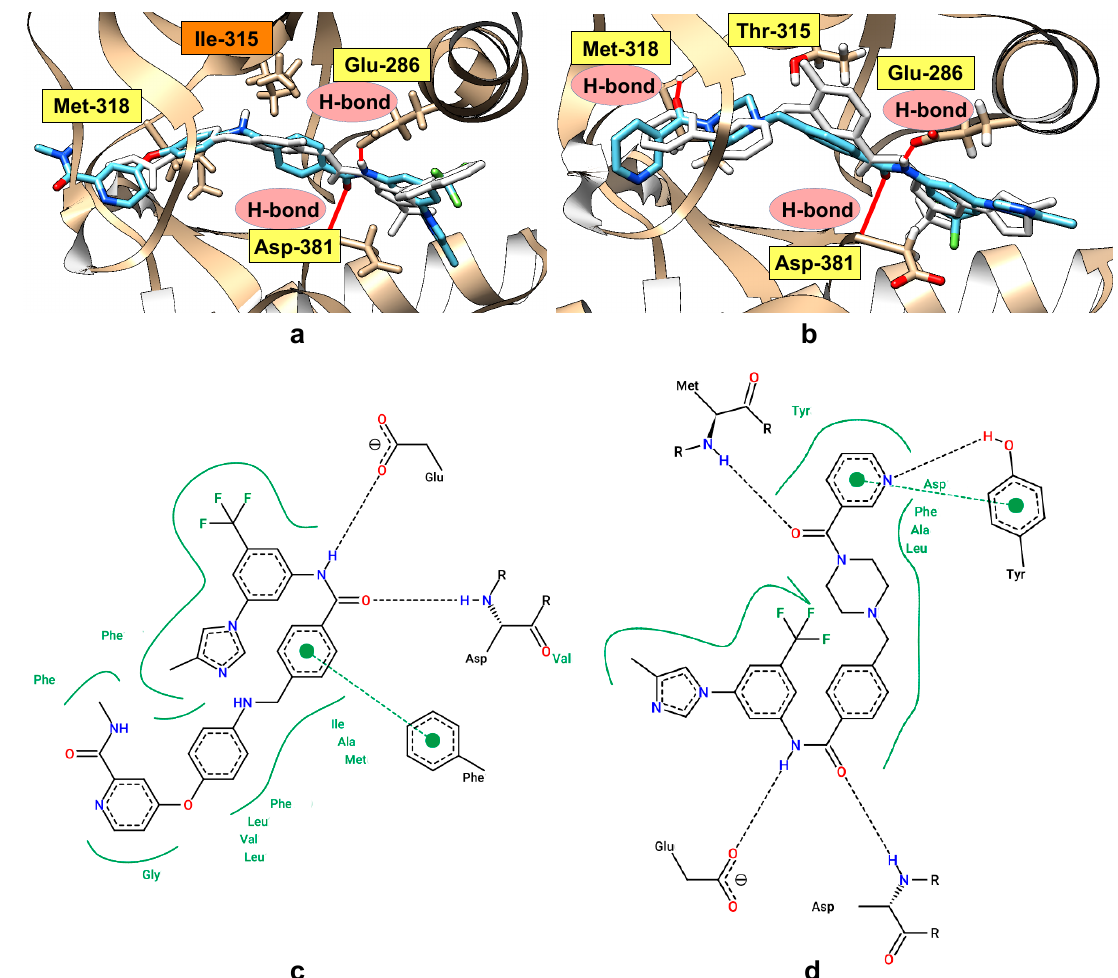
Figure 4. Binding models of inhibitor 10 and 28l to Abl kinase. Hydrogen bonds are indicated by red lines to key amino acids. ( a ) Binding model of 10 with T315I-mutant Abl (PDB: 3QRJ; H-bond—Asp-381, Glu-286). Experimental binding model of rebastinib is shown in white. ( b ) Binding model of 28l with Abl-wt (PDB: 3CS9; H-bond—Met-318, Asp-381, Glu-286). Experimental binding model of nilotinib is shown in white. ( c ) Two-dimensional interactions map of 10 with T315L-mutant Abl (PDB: 3QRJ; H-bond—Asp-381, Glu-286). ( d ) Two-dimensional interactions map of 28l with Abl-wt (PDB: 3CS9; H-bond—Met-318, Asp-381, Glu-286, Tyr-253).